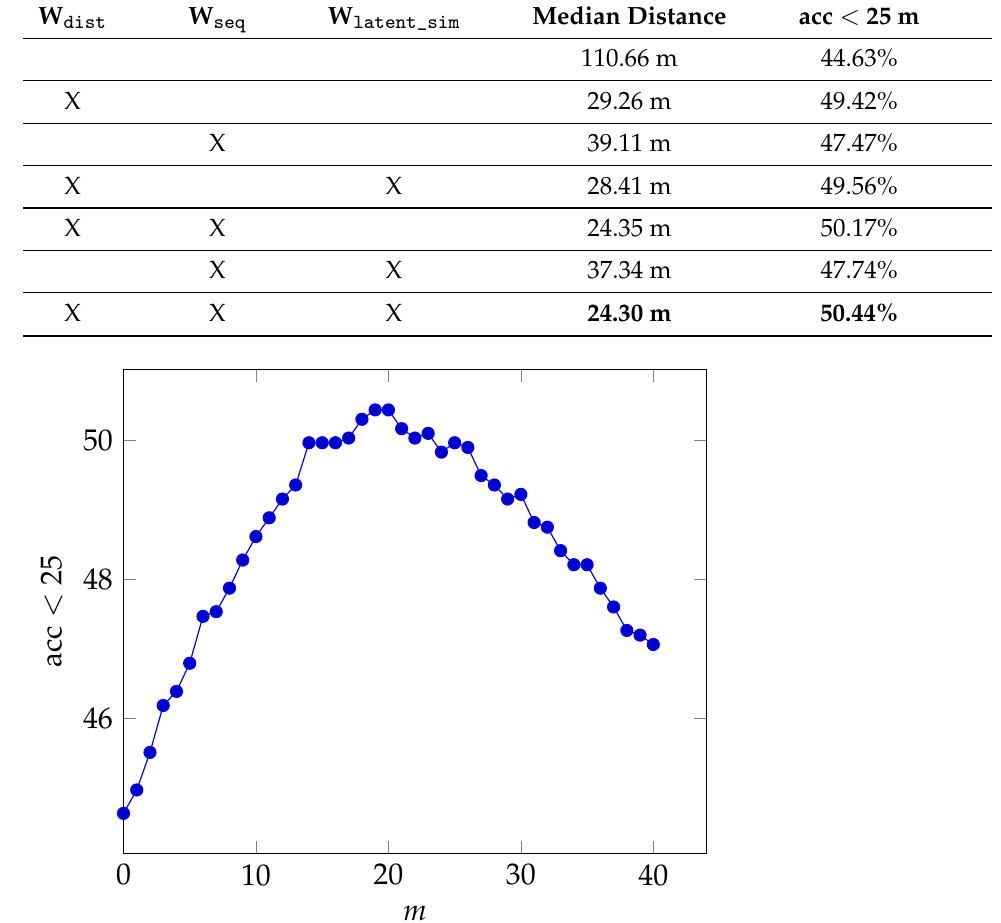
Figure 4. Effect of the parameter m on the retrieval accuracy under 25 m for the Adelaide test